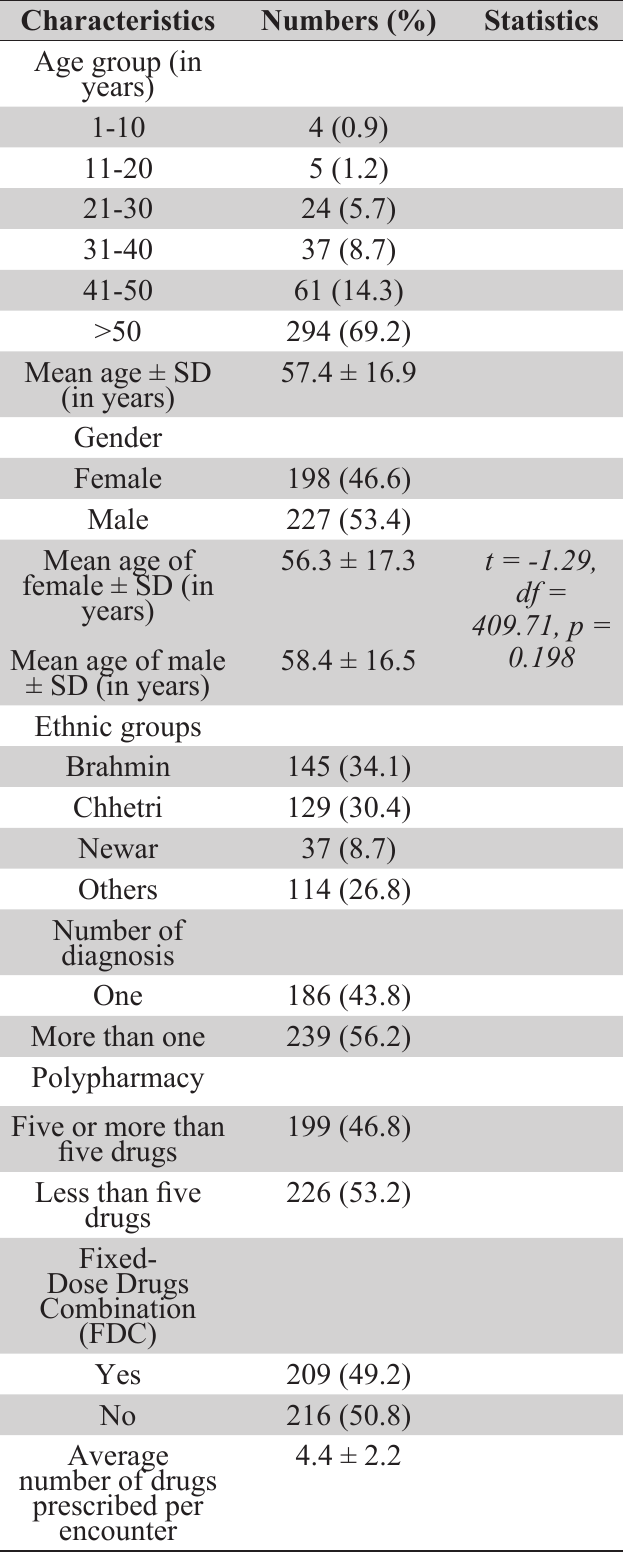
Table 1. Socio-demographic and